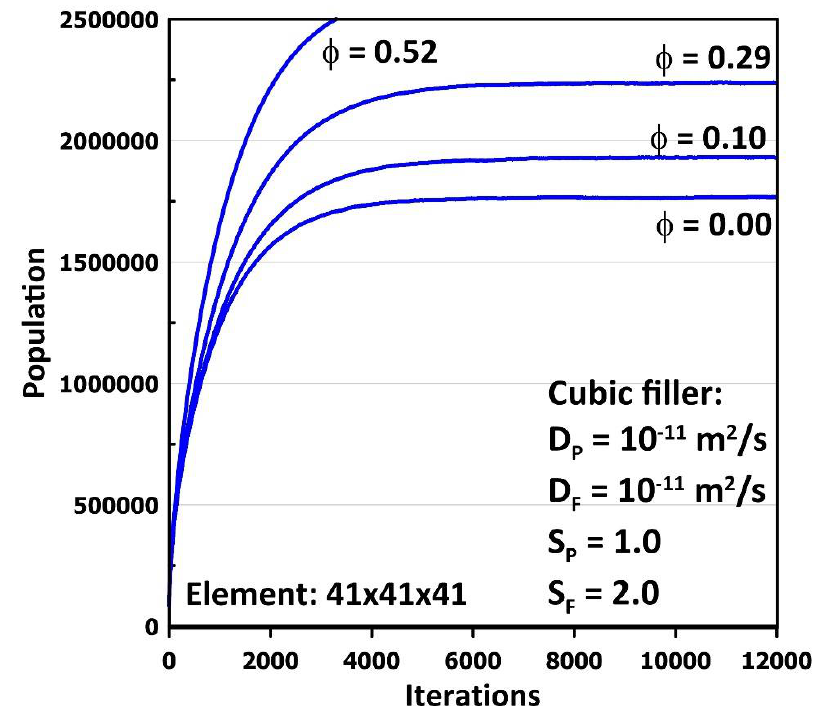
Figure 9. The plot of the population of molecules as a function of the number of iterations for different sizes of a cubic filler for the case where the solubility coefficient of the filler is twice that of the polymer.